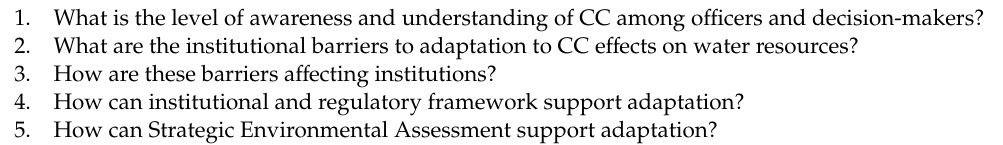
Table 3. List of sample guiding questions used in the